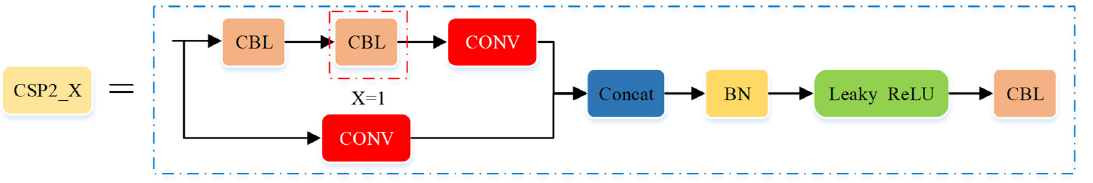
Figure 13. Structure of CSP2_X module.